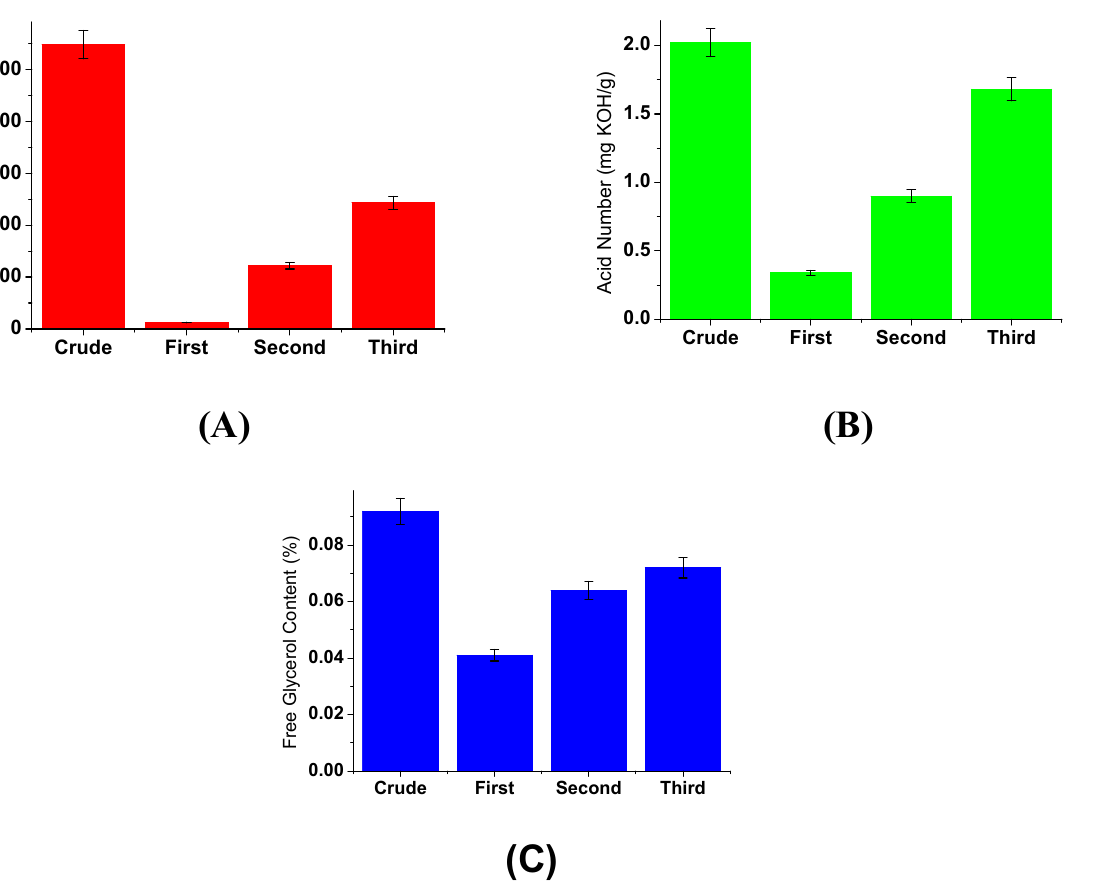
Figure 9. The adsorption capacity of regeneration of the IOCM of chitosan-silica: ( A ) soap level, ( B ) acid number, and ( C ) free glycerol content.